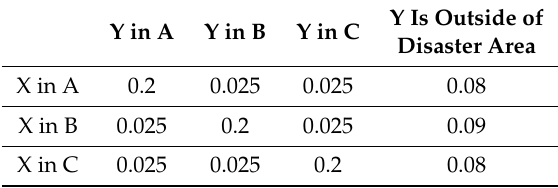
Table 2. Location distribution setup in area A, B, and C.